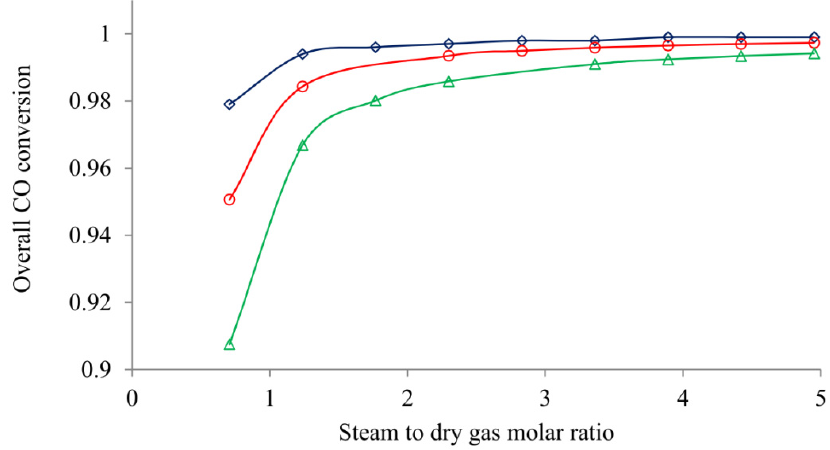
Figure 4. Effect of the steam to dry gas molar ratio over overall CO conversion, when an operating temperature of 473 K ( ◊ ), 523 K ( ○ ) and 573 K ( ∆ ) is established in the LT-WGS reactor with O to coal ratio: 0.8, solid concentration in coal slurry: 0.65, and 2 HTS reactor operating temperature: 623 K as fixed